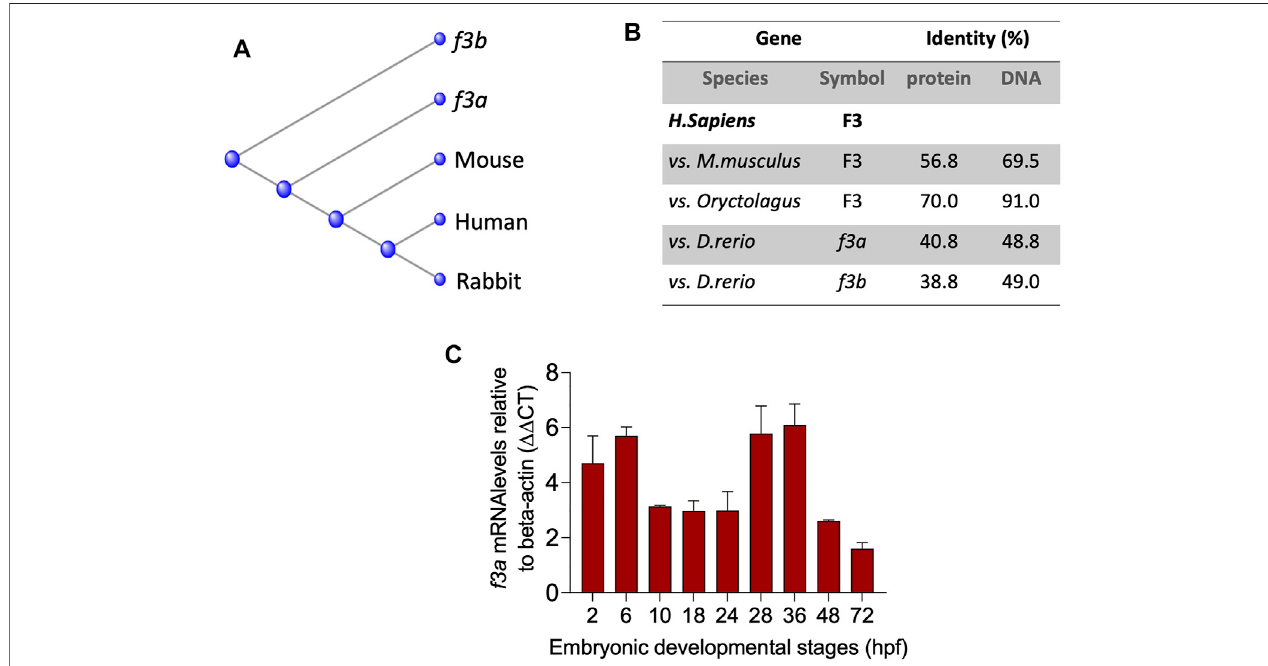
FIGURE1 | Evolutionaryrelationships and Spatiotemporalexpression ofZebra fi sh TF- f3b: (A) Phylogenetictree oftissuefactor (F3) from zebra fi sh (Danio), mouse (Mus), rabbit (Oryc), and human (Homo). (B) Protein and DNA percent identity of F3 from zebra fi sh (Danio), mouse (Mus), rabbit (Oryc), and human (Homo). (C) mRNA expression from whole embryos demonstrates that zebra fi sh f3a is expressed in early embryonic stages. Beta-actin was used to normalize the expression of f3a .